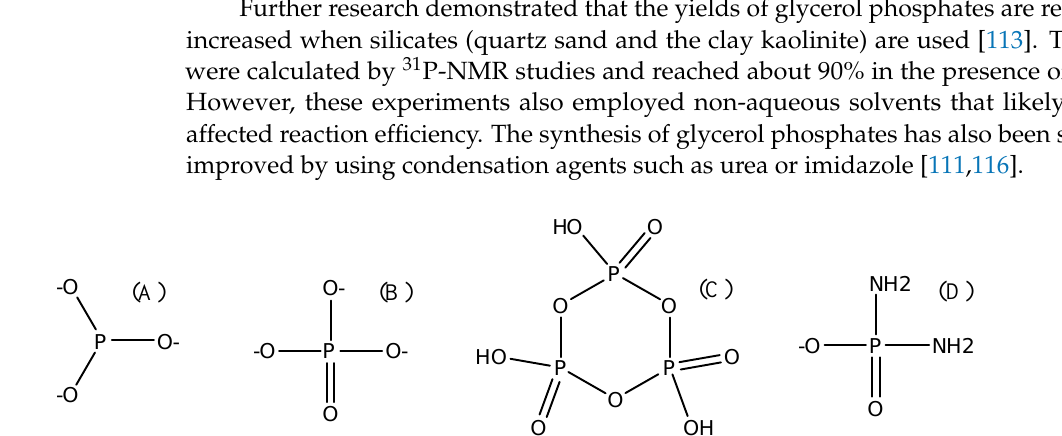
Figure 8. Structures of various forms of inorganic phosphorus compounds discussed in the text: ( A ) phosphite ion which is a reduced form of phosphorus, found in meteorites and in other natural sources, ( B ) orthophosphate ion, ( C ) cy- clotrimetaphosphate, a high-energy condensed phosphate, and ( D ) diamidophosphate, which is a form of high-energy